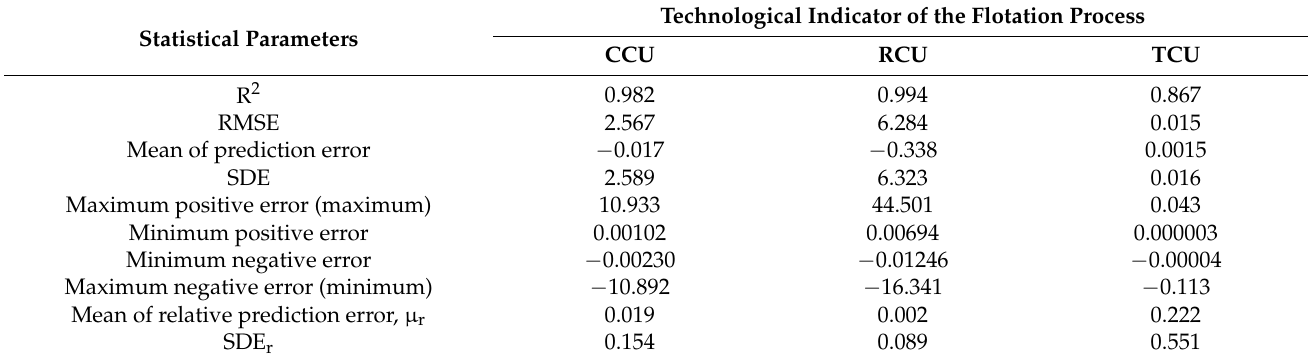
Table 10. Statistical analysis of actual and predicted values using NN1, NN2 and NN3 models.